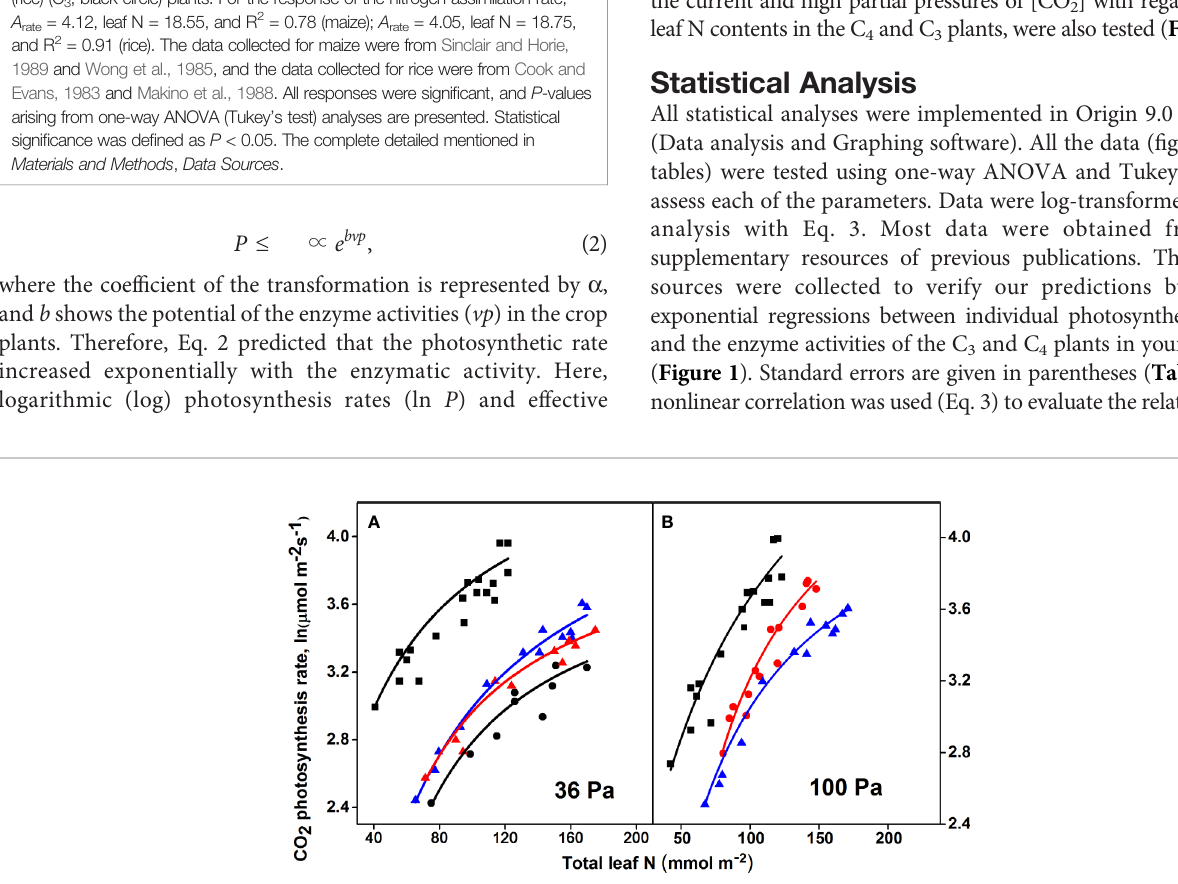
FIGURE 4 | The response of the logarithmic-maximum photosynthetic rates to current (36 Pa) and elevated partial pressure (100 PaCO 2 ) when the total leaf N was limited in the young leaves of C 3 and C 4 plants: (A) Zea mays (black squares, C 4 ), Oryza sativa (blue triangle, C 3 ), Spinacia oleracea (red triangle, C 3 ), and Phaseolus vulgaris (black circles, C 3 ); (B) Zea mays (black squares, C 4 ), anti-rbcS 77 which is rbcS antisense rice with 65% wild-type Rubisco (red circles, C 3 ), and O. sativa (blue triangles, C 3 ). One-way ANOVA represents statistical differences ( P < 0.05) by Tukey ’ s test and best R 2 . All the parameters are given in Table 2 . The data were collected from Makino et al., 2003, and at 36 Pa for rice were from Makino et al., 1997 and at 100 Pa for rice including rbc S antisense rice from Makino et al., 1997. The complete detailed mentioned in Materials and Methods , Data Sources .